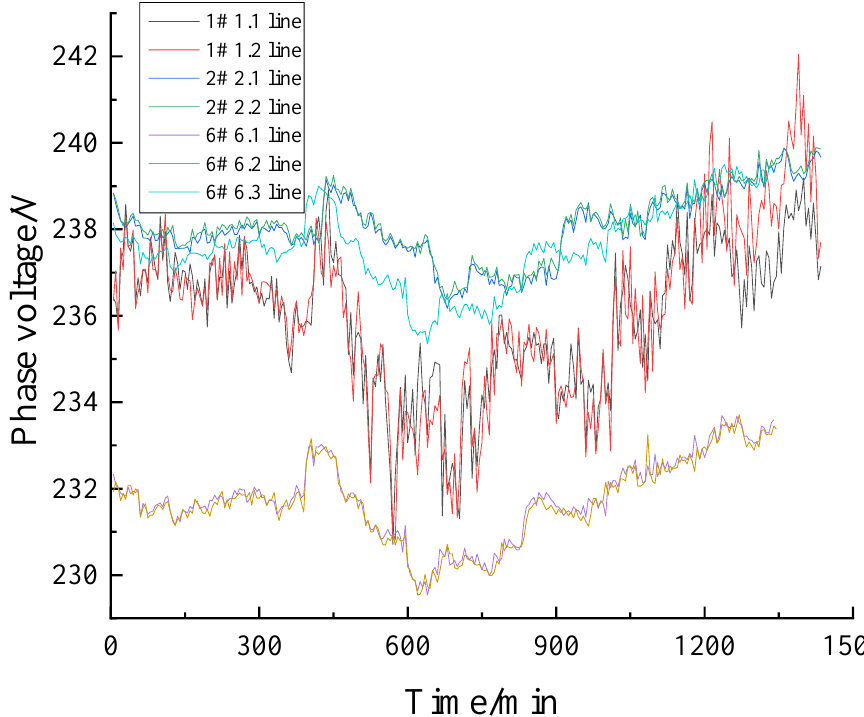
Figure 4. Multi-station-area voltage distribution curves. the following aspects: (1) The voltage value of the transformer busbar in different station areas; (2) The sum of the upstream transmission power of the low-voltage distribution line of the phase line; (3) The upstream line loss of the low-voltage distribution line of the phase line. Therefore, when the electrical distance between the two voltage nodes is relatively close (the distance between the two voltage nodes is relatively close, and the sum of the upstream transmitted power and the line loss are not significantly different), the voltage changes in the two nodes are similar [21], and the line voltage changes in the same phase in the same station area are more similar [20]. Affected by the three-phase unbalance in the station area, there is a voltage difference between the low-voltage busbar of the distribution transformer at the same time between two similar points, so the voltage of two points with a close electrical distance or different phase lines of the same point may also be different, as is shown in Figure 5. The three-phase voltage change curve of the 1#A line is shown in Figure 4. Therefore, the identification of phase line plays an important supporting role in the identification of low-voltage distribution network